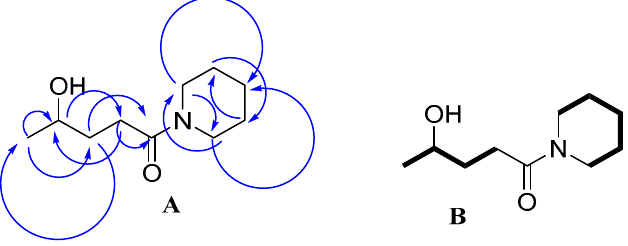
Figure 7. ( A ) Important HMBC correlations; ( B ) COSY correlations (Bold line).